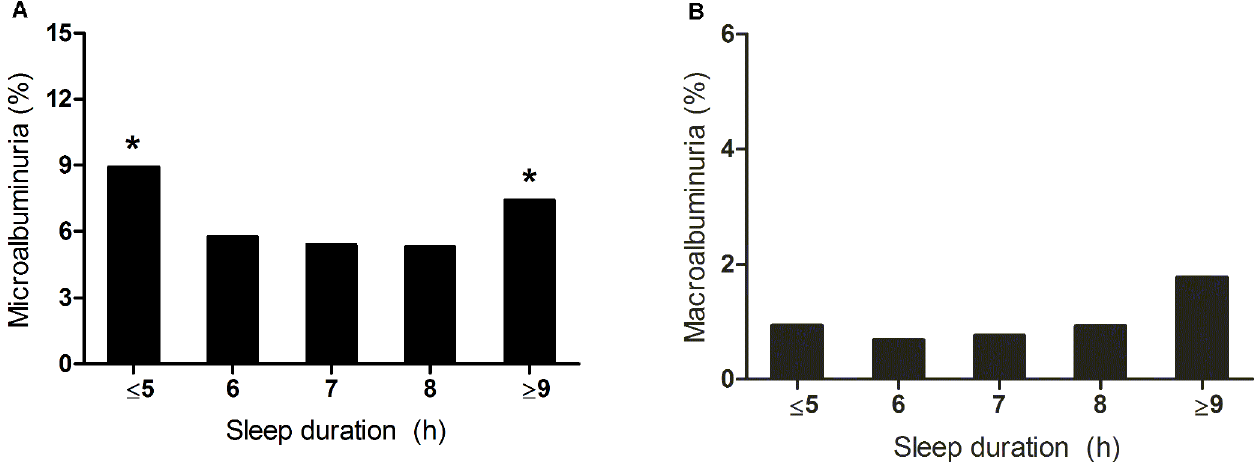
Fig 1. Proportion of patients with microalbuminuria (A) or macroalbuminuria (B) according to sleep duration. Microalbuminuria was defined as 30mg/g (cid:20) urinary albumin-creatinine ratio (UACR) < 300 mg/g, and macroalbuminuria was defined as UACR (cid:21) 300 mg/g. (cid:3) P < 0.005 vs. sleep duration of 7 hours per